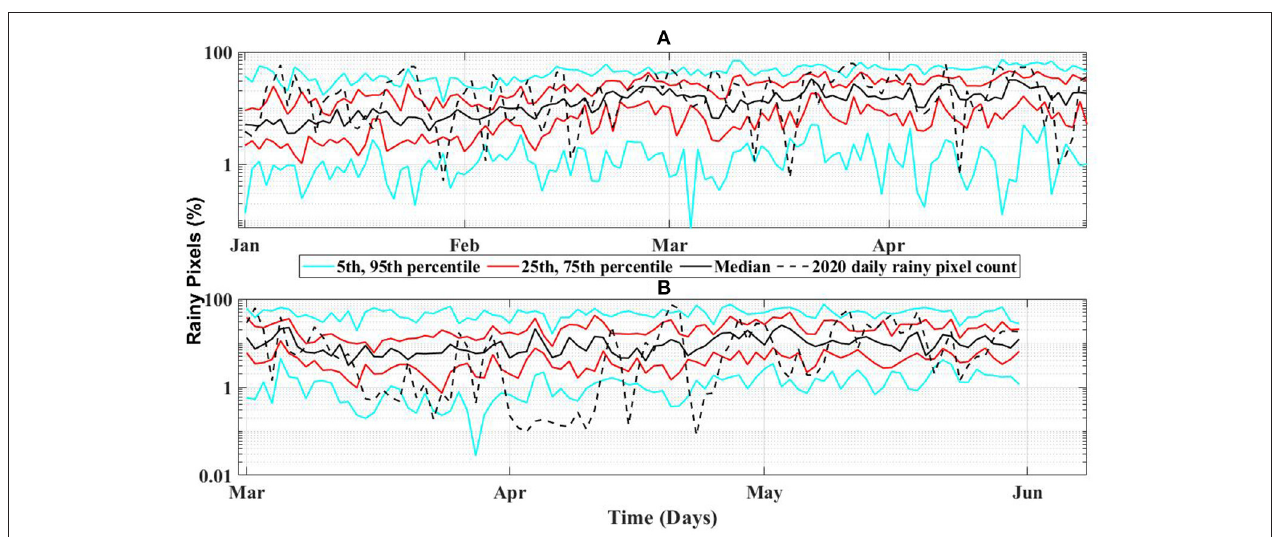
FIGURE 5 | Time series of rainy pixels (in %) across the (A) Hubei Province, China and (B) Northern Italy, showing the 5th, 25th, 50th (median), 75th, and 95th percentiles of the precipitation distribution observed during the springs of 2001-2019 and the daily rainy pixel count during spring 2020 (dashed black line).